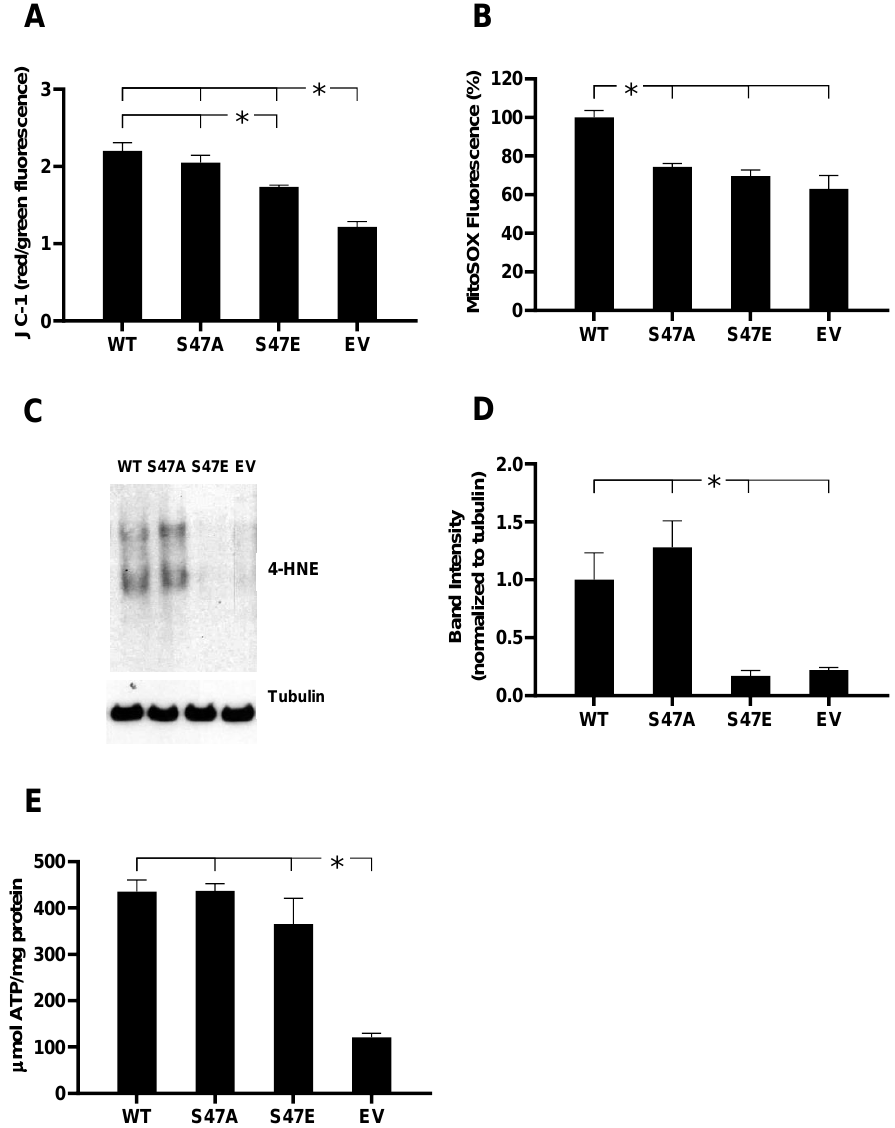
Figure 2. ( A ) Mitochondrial membrane potential ( ∆Ψ m ) of intact cells measured using red / green fluorescence distribution of the ratiometric JC-1 probe ( n = 6). ( B ) Mitochondrial reactive oxygen species (ROS) production in intact cells measured as % of MitoSOX fluorescence ( n = 4). ( C ) 4-hydroxynonenal (4-HNE), a product of lipid peroxidation, immunoblotted on cells stably expressing EV and WT, S47A, S47E Cyt c . ( D ) Quantification of 4-HNE band density using ImageJ software ( n = 3). ( E ) ATP levels in the cell lines stably expressing EV and WT, S47A, S47E Cyt c ( n = 3). Data are represented as means ± SEM, * p <